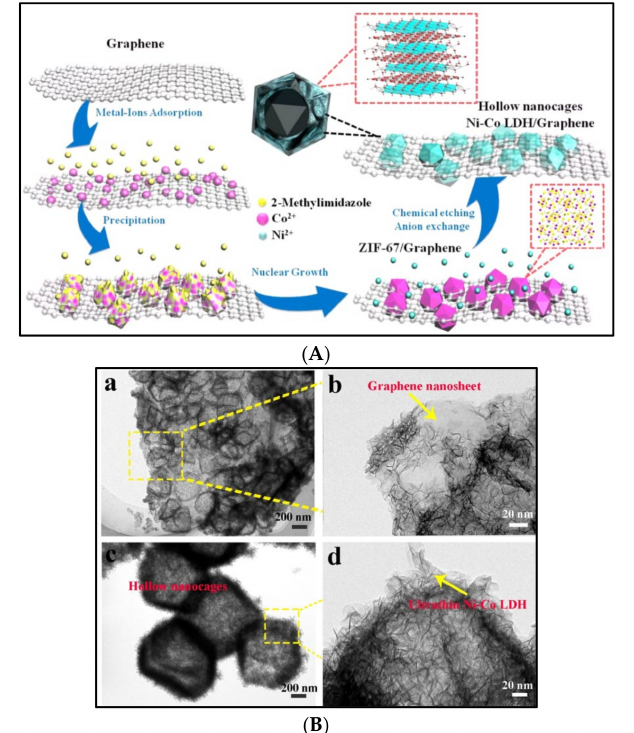
Figure 6. ( A ) Schematic illustration of the synthesis procedure of the Ni-Co LDH hollow nanocages/graphene composite [34]. ( B ) TEM images of Ni-Co LDH hollow nanocages/graphene composites with different magnification ( a – d ) [34]. Reprinted (adapted) with permission from Xue Bai, Qi Liu, Zetong Lu, et al. Rational Design of Sandwiched Ni-Co Layered Double Hydroxides Hol- low Nanocages/Graphene Derived from Metal-Organic Framework for Sustainable Energy